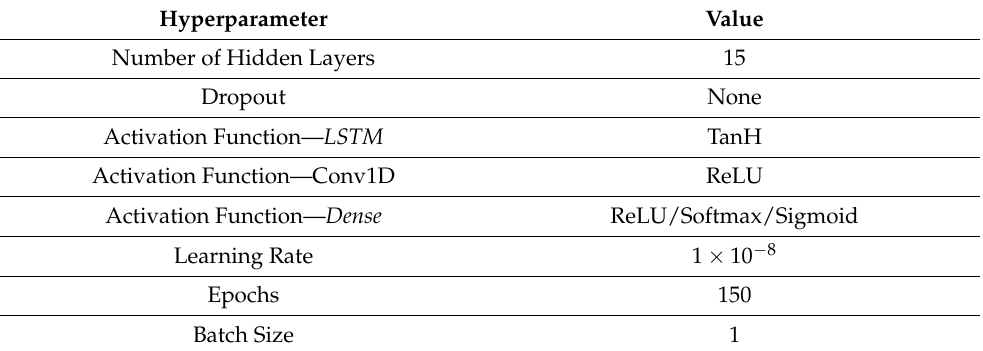
Table 7. CNN - LSTM SI